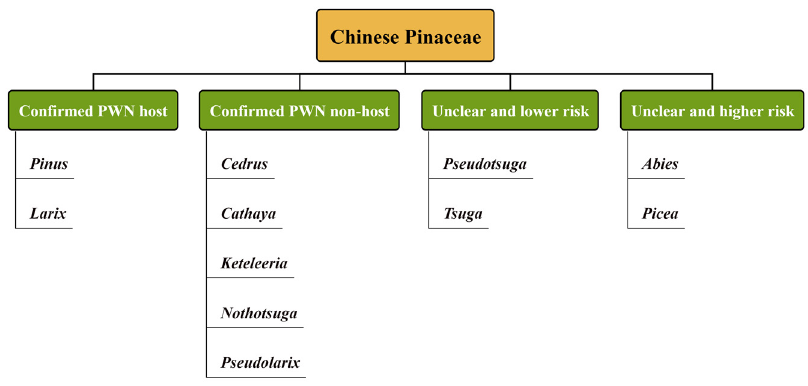
Figure 2. Relationship of PWNs and the genera of Pinaceae in China.